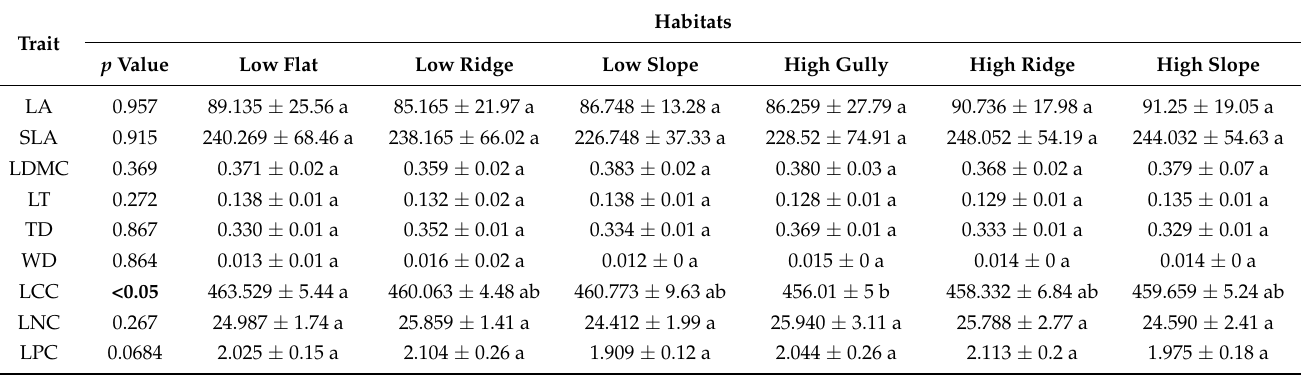
p values indicate the significance, and different letters represent significant difference in different habitats. Trait abbreviations: SLA (specific leaf area); LDMC (leaf dry matter content); LA (leaf area); LT (leaf thickness); TD (leaf tissue density); LCC (leaf carbon concentration per unit leaf mass); LNC (leaf nitrogen concentration per unit leaf mass); LPC (leaf phosphorus concentration per unit leaf mass); and WD (wood